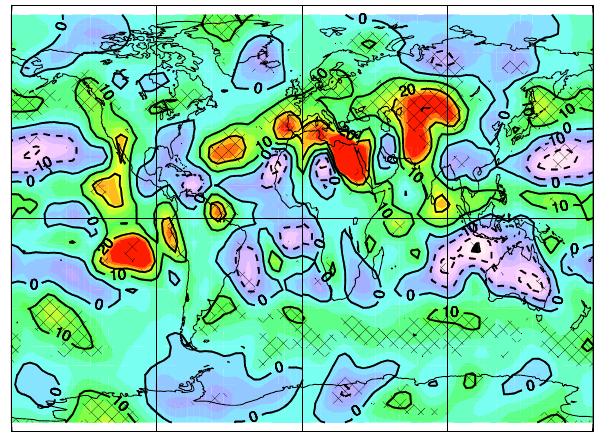
Fig. 10. Precipitation difference (mms − 1 ) between scenario and reference simulations averaged over time period 2090–2100 (an- nual mean). Hatching represent the areas where the statistical sig- nificance exceed 95% level.